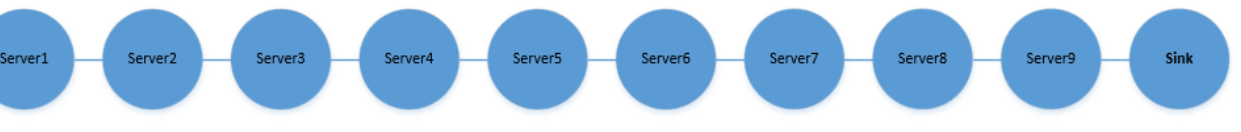
Figure 3. Scenario 1: linear topology with 10